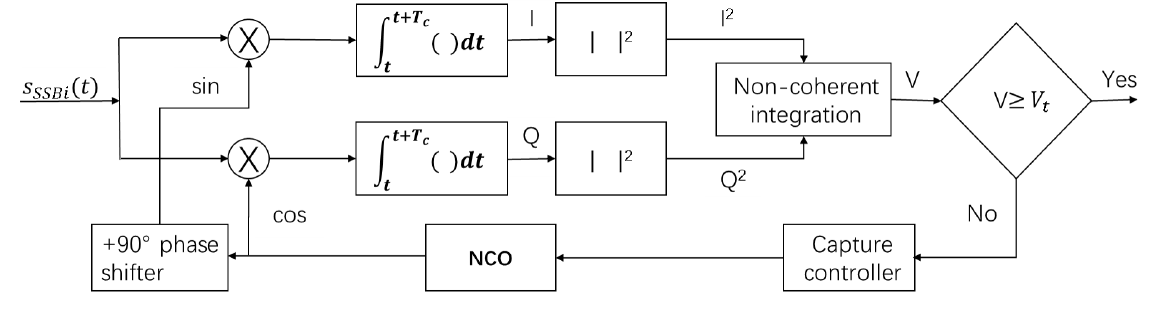
Figure 3. Typical of signal acquisition block